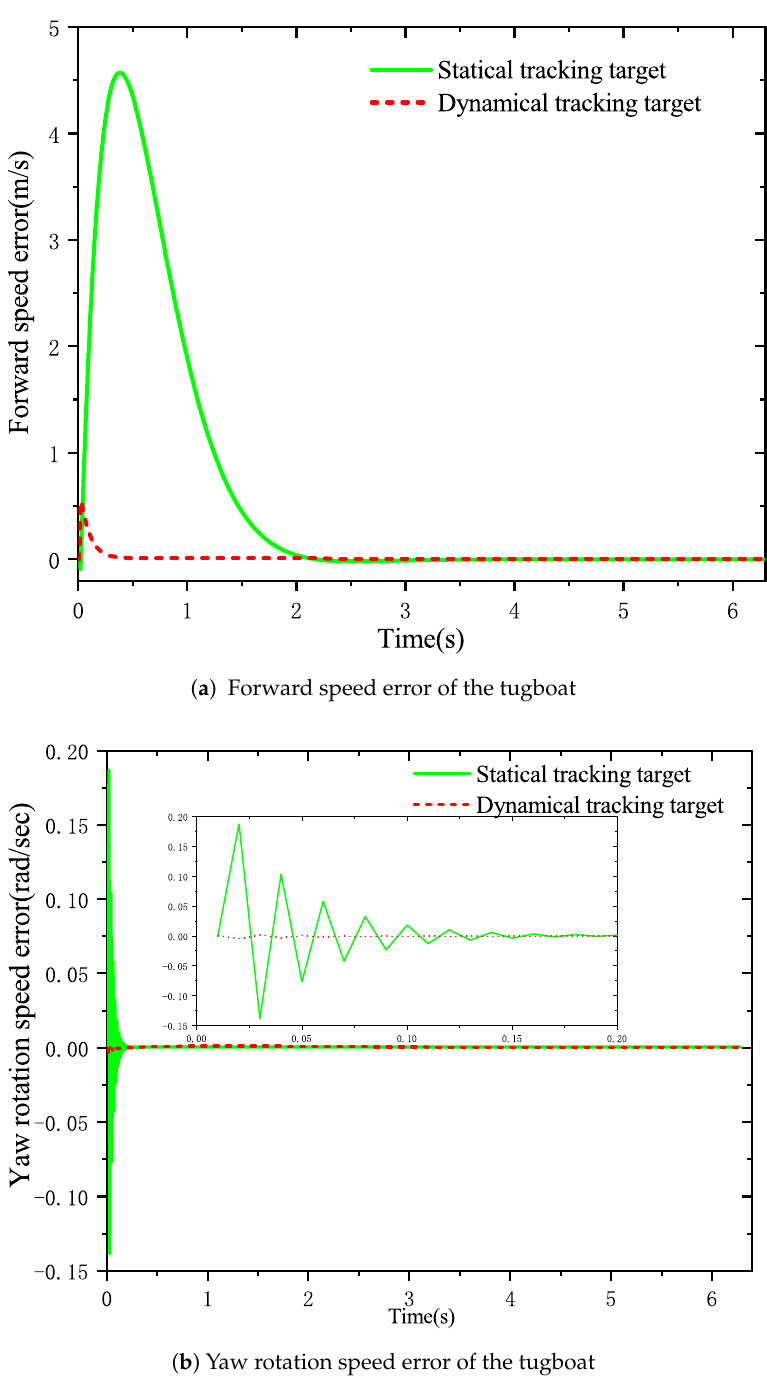
Figure 3. Actual speed error of the